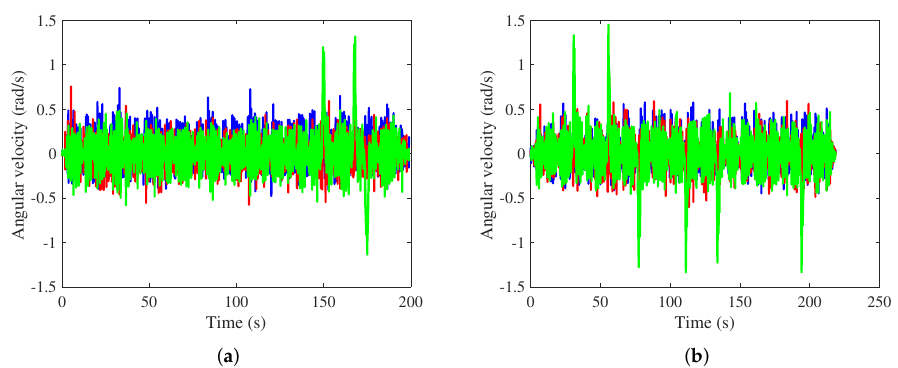
Figure 8. Angular velocity in the office building A and B. ( a ) Office building A; ( b ) Office building B.